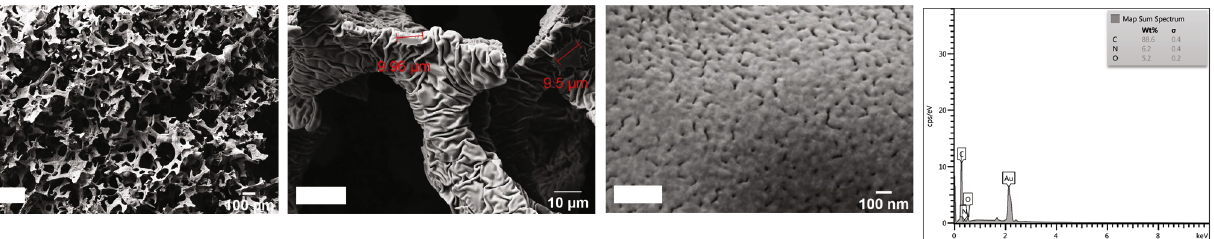
Figure 17: SEM images and energy-dispersive spectroscopy (EDS) analysis of PURFs